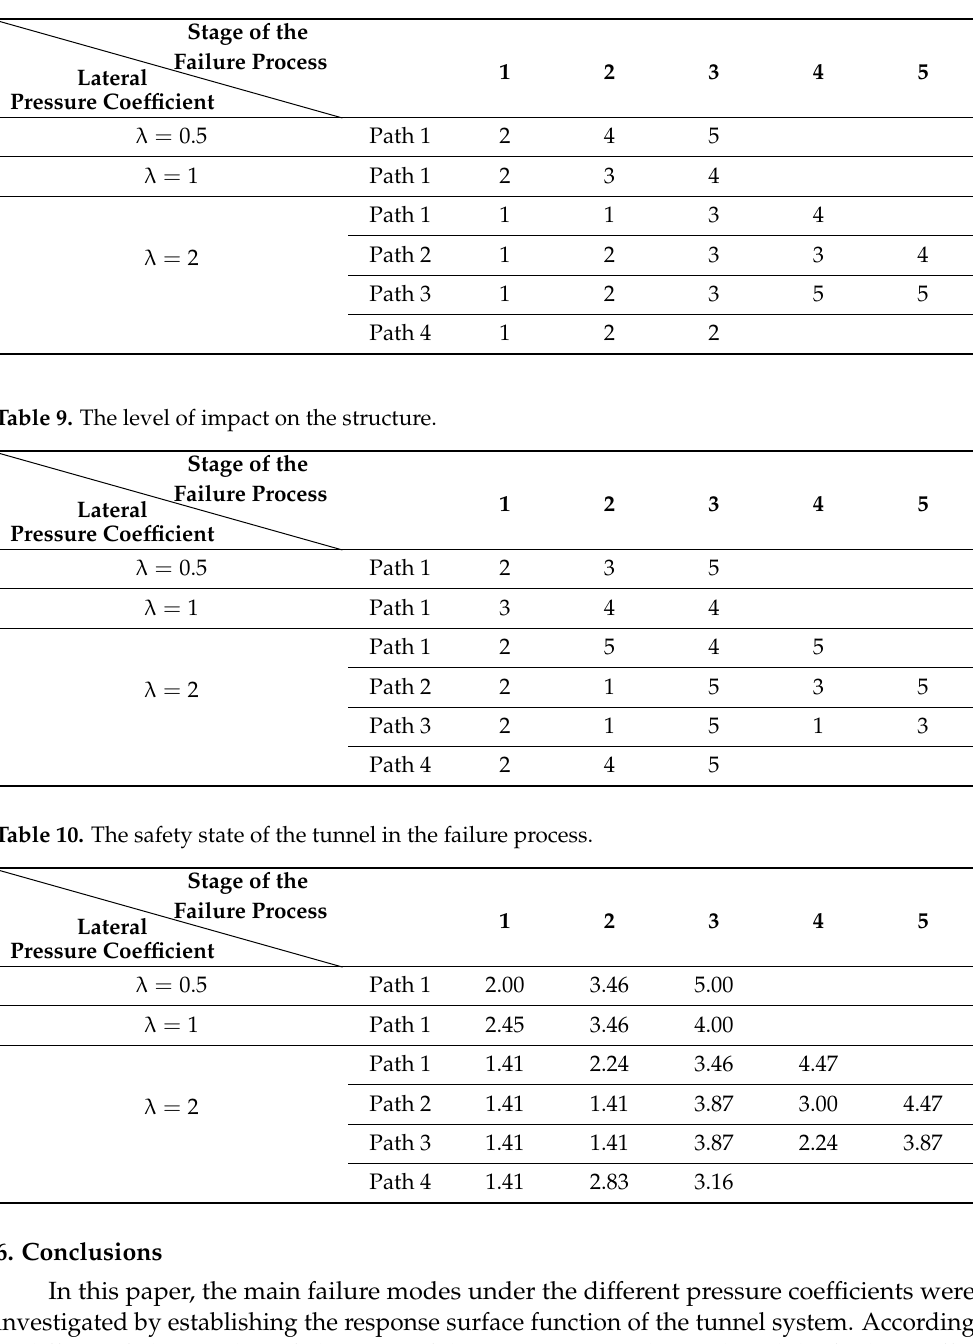
Table 8. The safety state of the failed parts.